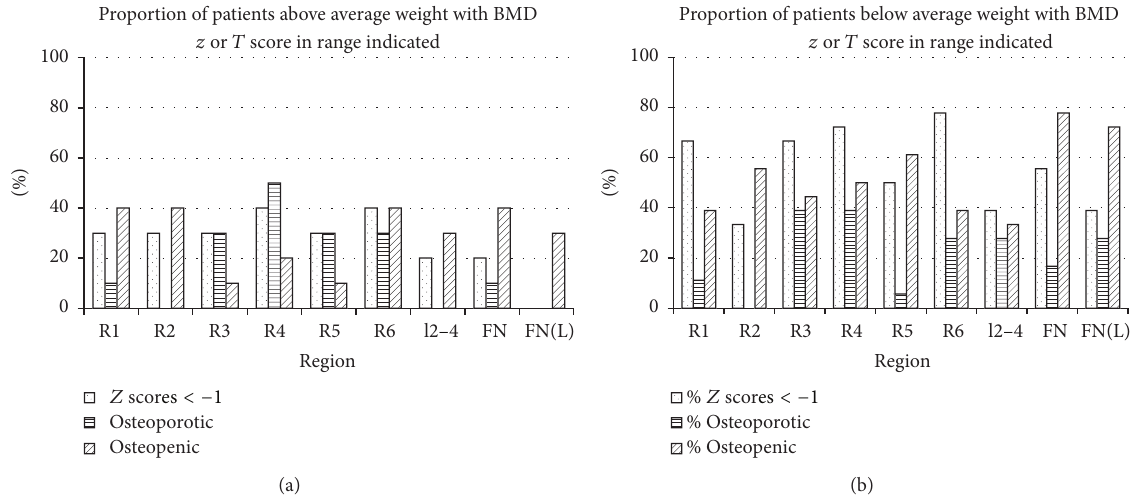
Figure 2: Proportion (as %) of patients with osteoporosis ( 𝑇 score − 2.5 or lower), osteopenia ( 𝑇 score − 1 to − 2.499), or a 𝑧 score below − 1. R1–R6 indicate the regions of the lower limb (see Section 2). l2–4 refers to lumbar vertebrae 2–4 inclusive; FN: femoral neck. FN(L) refers to 𝑇 scores calculated from the data of Looker et al. 1997. 𝑍 and 𝑇 scores were calculated as described in Section 2 from control subjects [18, 19] or for FN(L) from [21]. (a) Patients with above average weight and (b) patients with below average